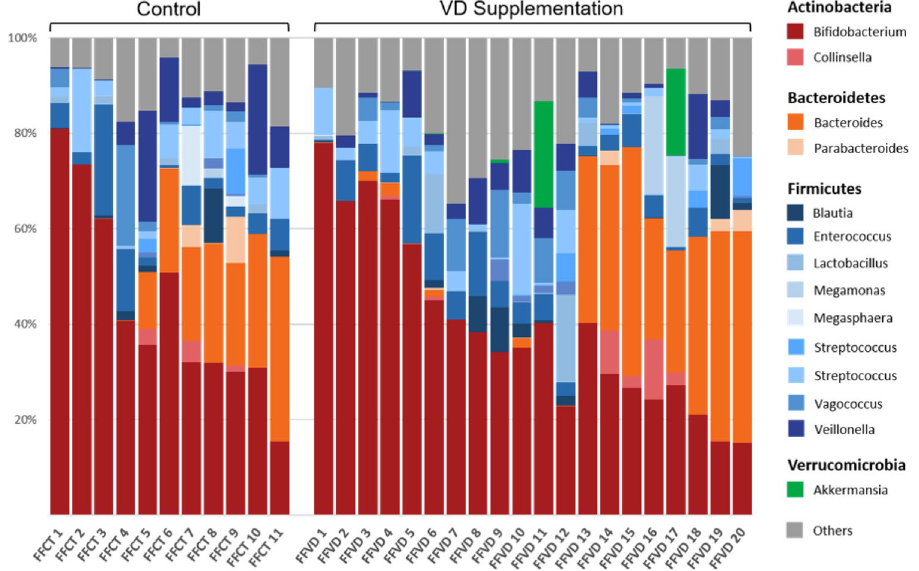
Figure 7. Taxonomic distribution of bacterial communities in fecal samples from formula-fed infants with vitamin D